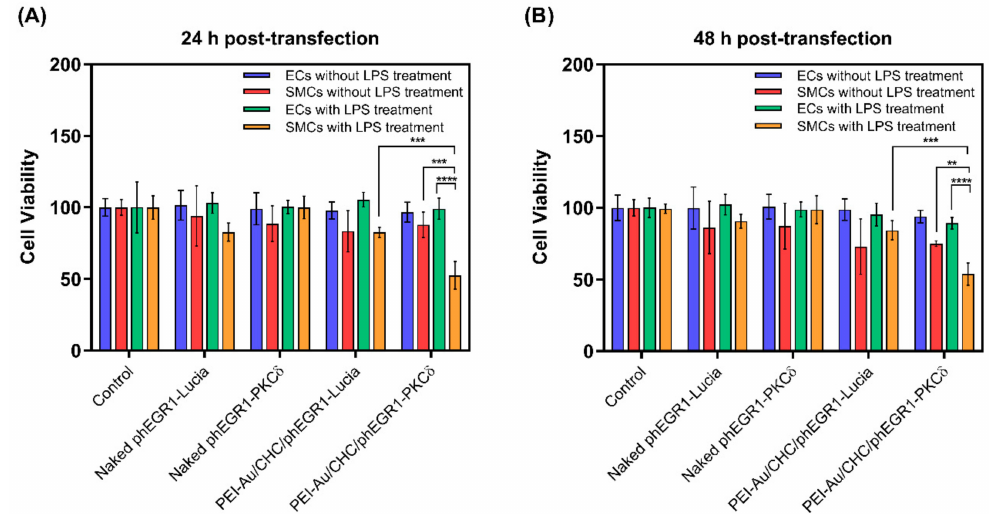
Figure 5. The in vitro inhibition e ff ect of the PEI-Au / CHC / phEGR1-PKC δ complex on the smooth muscle cells and endothelial cells was evaluated with PrestoBlue ® reagent at ( A ) 24 h and ( B ) 48 h after transfection. The cell viability of endothelial cells and smooth muscle cells treated with di ff ering PEI-Au / CHC / DNA complexes was assessed. Cells were treated with lipopolysaccharides (LPS) to simulate the inflammatory environment. ** p ≤ 0.01, *** p ≤ 0.001, **** p ≤